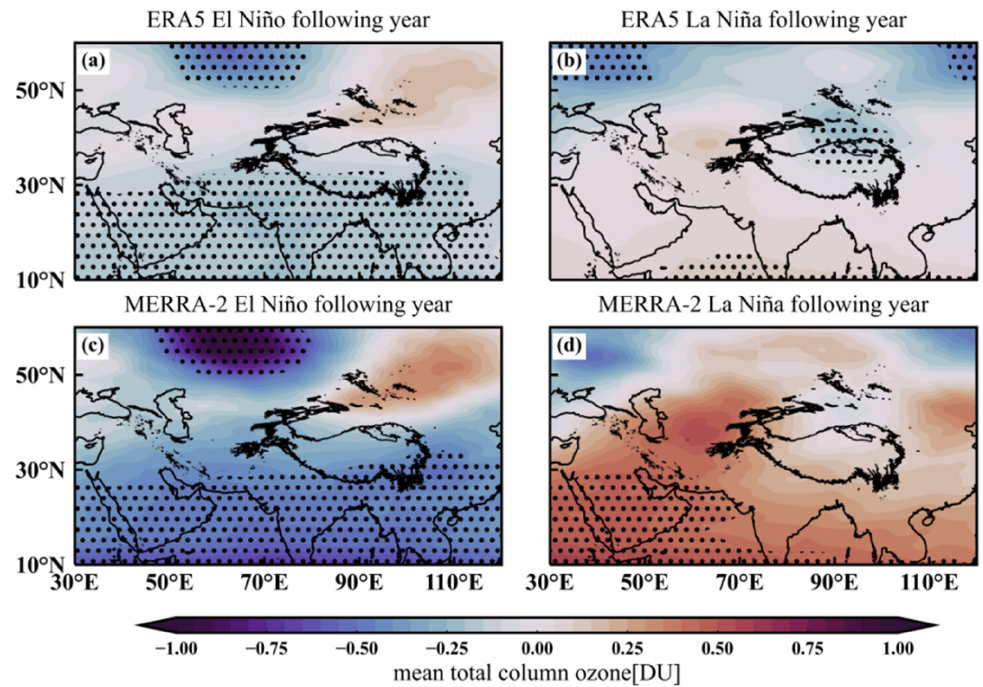
Figure 4. Composite O 3 anomalies in the summers following El Niño and La Niña (unit: DU). ( a ) El Niño based on ERA5, ( b ) La Niña based on ERA5, ( c ) El Niño based on MERRA-2, ( d ) La Niña based on MERRA-2. The black-dotted regions are statistically significant at the 95% confidence level ( t - test).